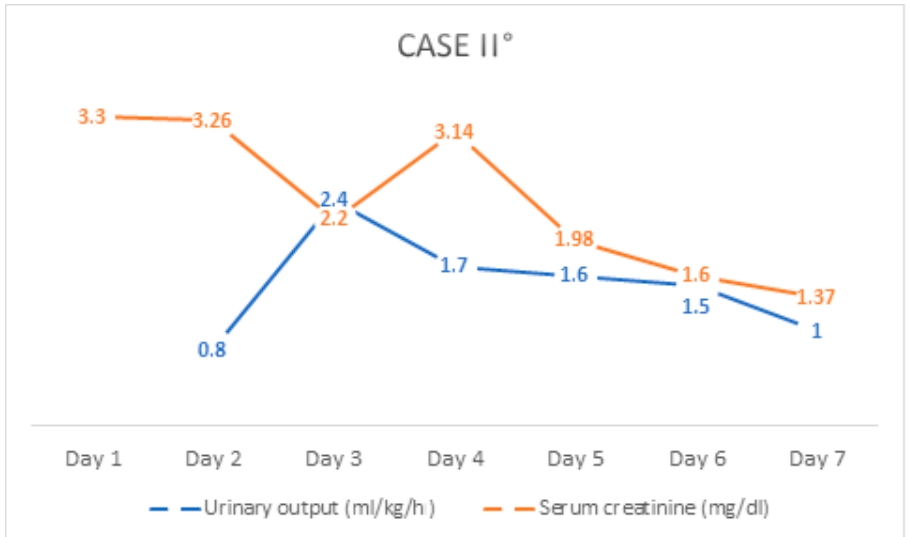
Figure 5. The course of serum creatinine value and urinary output of Case II° during hospitalization.